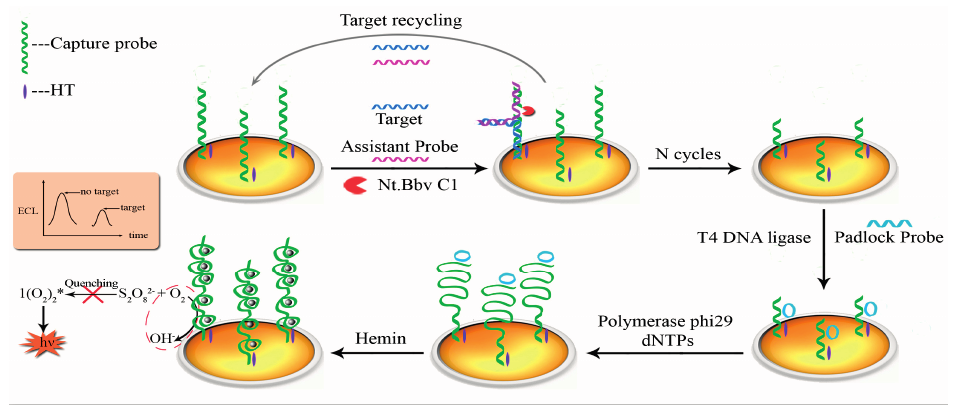
Figure 1. Illustration of the dual signal amplification strategy for specific DNA detection based on the Nt.BbvCI-assisted recycling amplification (TRA), rolling circle amplification (RCA) reaction and the formation of